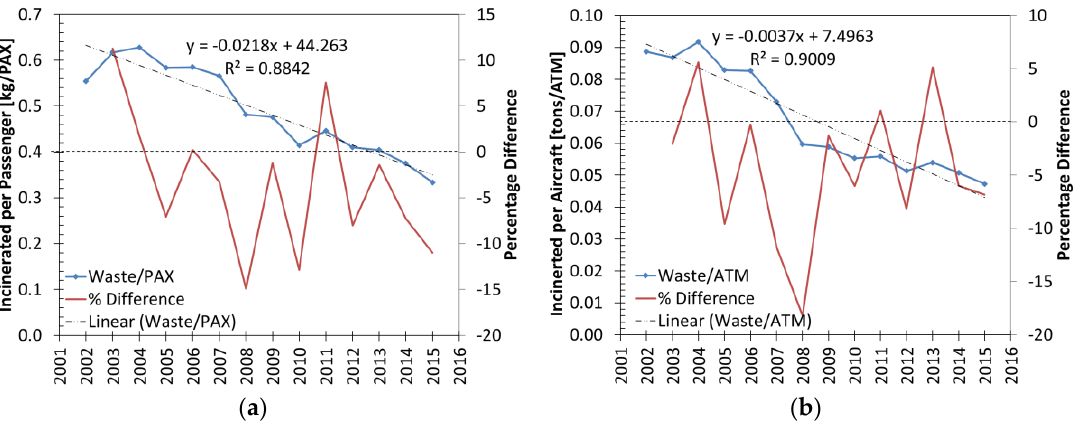
Figure 5. Incinerated waste and year on year percentage difference at Kansai International Airport during 2002–2015: ( a ) per passenger; and ( b ) per aircraft movement. Source: Data derived from [60,66].